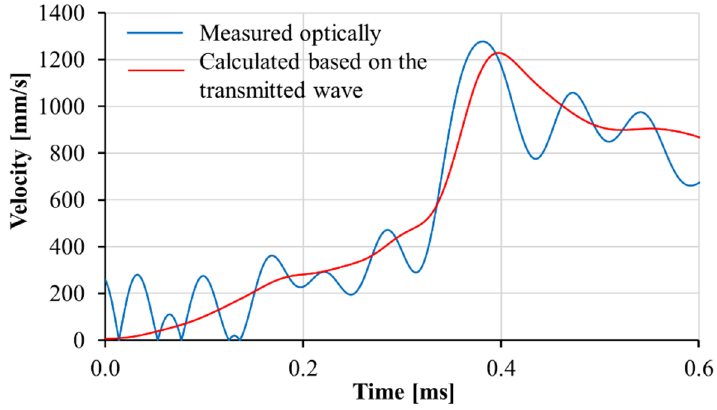
Figure 15. Results of a calibration test showing agreement between the velocity of the adapter measured optically and that calculated based on the transmitted wave.